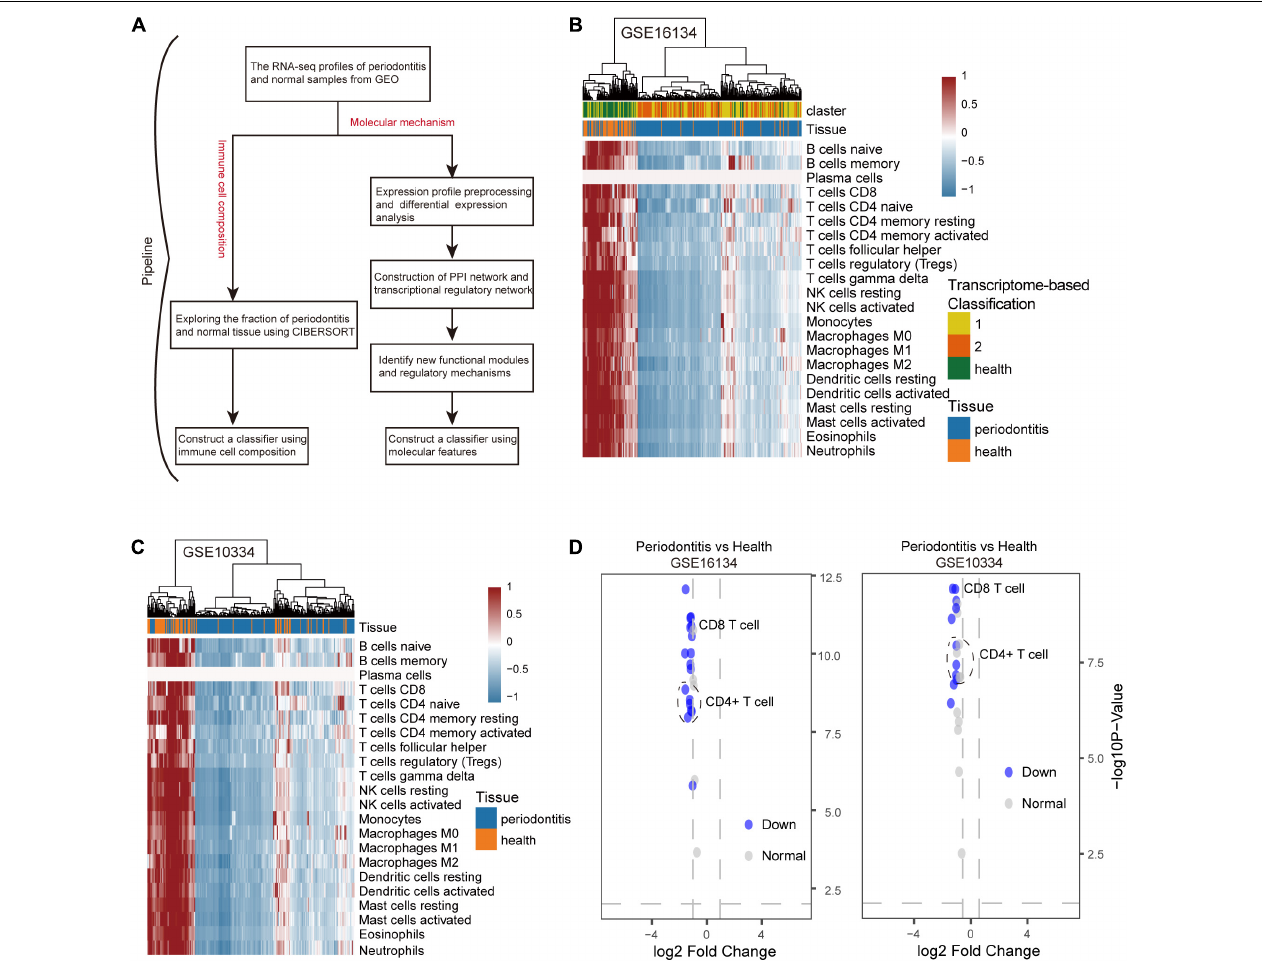
FIGURE 1 | The distribution of 22 types of immune cells in periodontitis and healthy samples. (A) Diagram of the multiple components and workflows of pipeline. (B) The heatmap represents the fraction of immune cells for the GSE16134 series. The horizontal axis is the immune cell type and the vertical axis is the sample. (C) The same as in (B) but for GSE10334. (D) The volcano plot represents the immune cells with significantly different gene expression levels between periodontitis and healthy samples for the GSE10334 and GSE16134